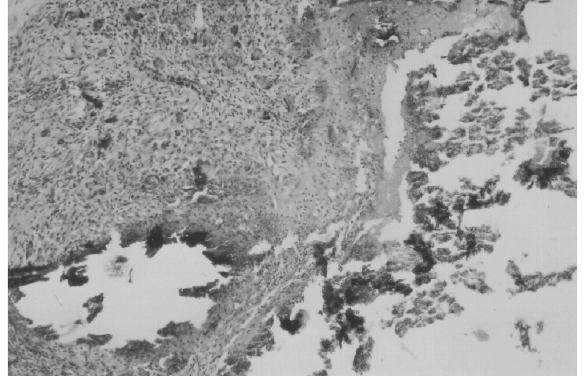
FIGURA 4- Sealapex – 21 dias: evolução por colagenização. Infiltrado difuso mononuclear. Atividade macrofágica sobre o material extravasado. HE Nikon 80x